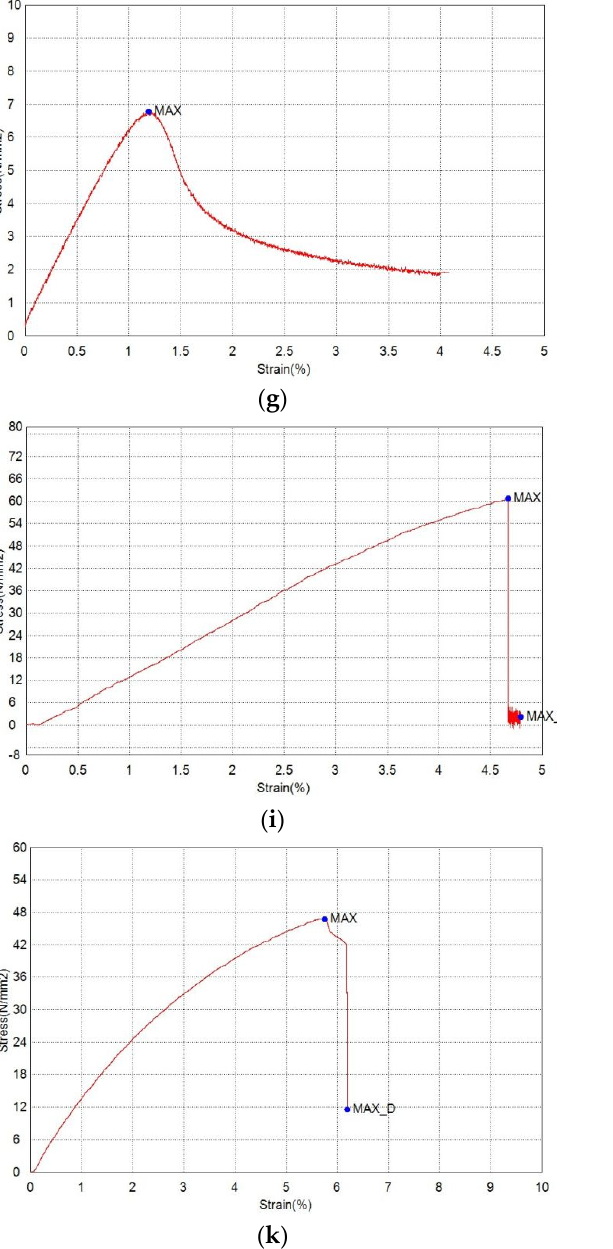
Figure 3. ( a − d ) Tensile strength graph of JCJC spent tea leaf composites: ( a ) S1, ( b ) S2, ( c ) S3, and ( d ) S4; ( e − h ) compression strength graph of JCJC spent tea leaf composites: ( e ) S1, ( f ) S2, ( g ) S3, and ( h ) S4; ( i − l ) bending strength graph of JCJC spent tea leaf composites: ( i ) S1, ( j ) S2, ( k ) S3, and ( l ) S4.